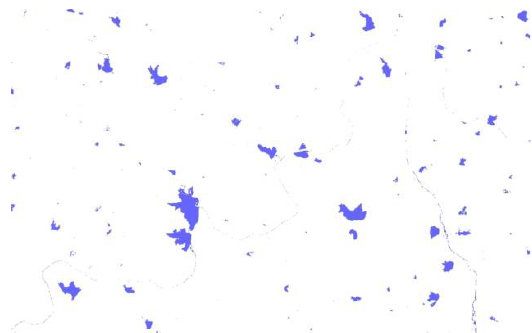
Figure 9: Reference image (Source: EC JRC/Google)